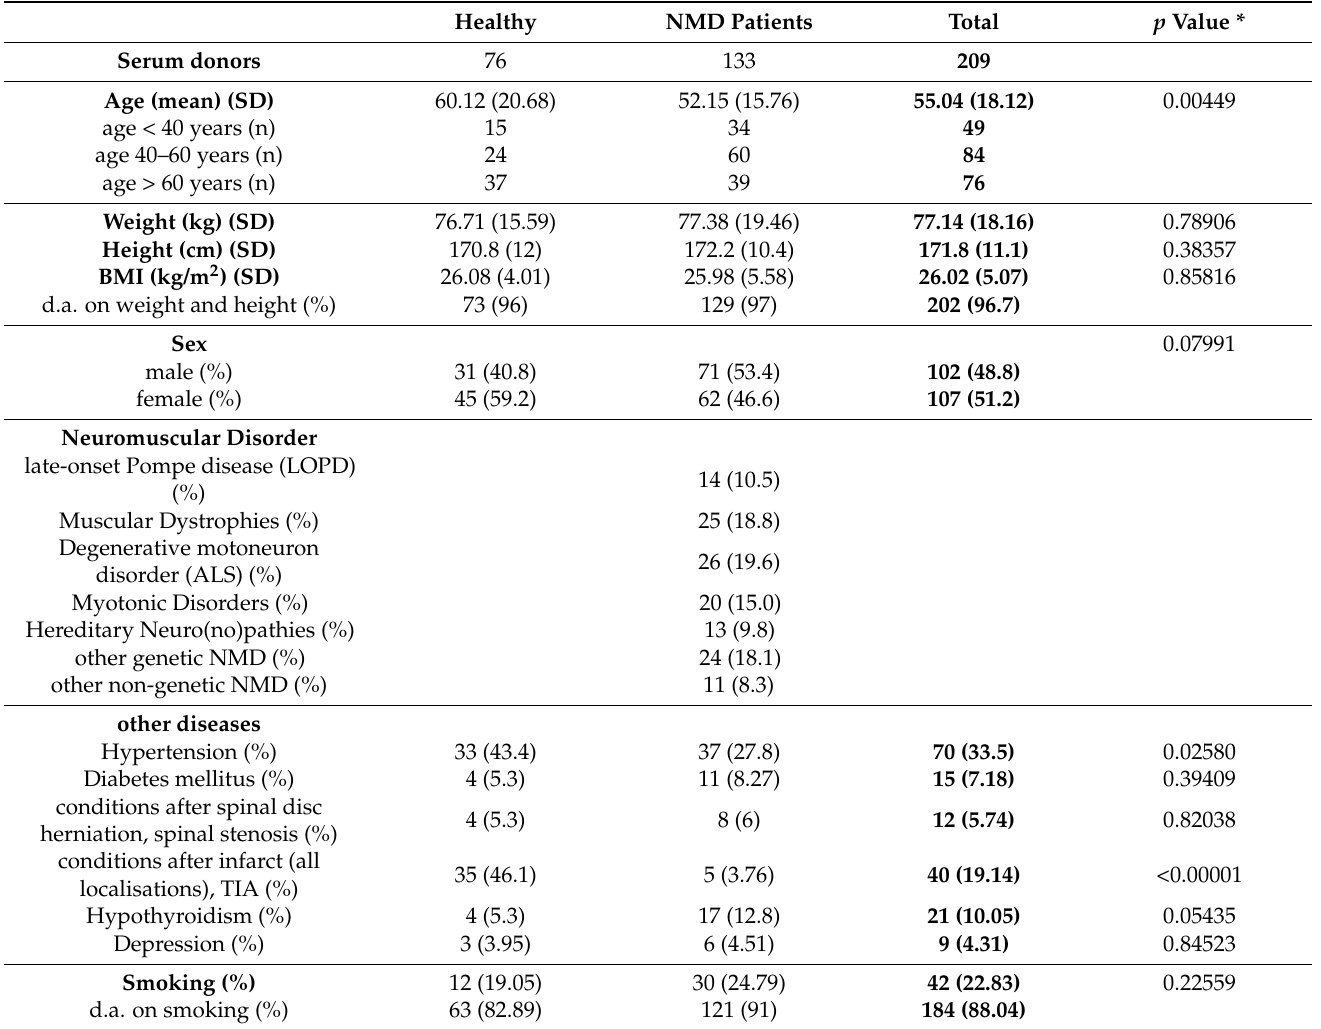
Table 1. Characteristics of the serum donor cohort. NMD: neuromuscular disorder, SD: standard deviation, TIA: transient ischaemic attack, d.a.: data